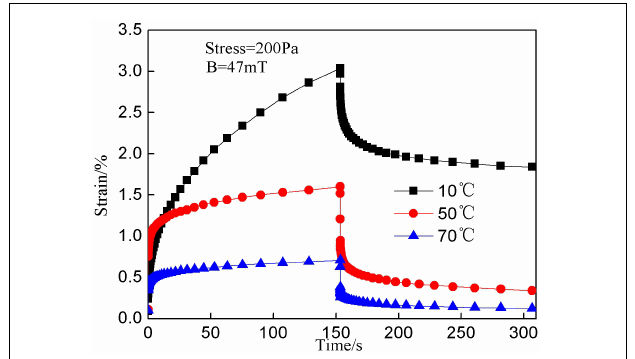
FIGURE 11 | The creep and recovery curves of MRG-70 under a 200 Pa constant stress for MRG-70 under different temperatures T = 10 ◦ C; T = 50 ◦ C; T = 70 ◦